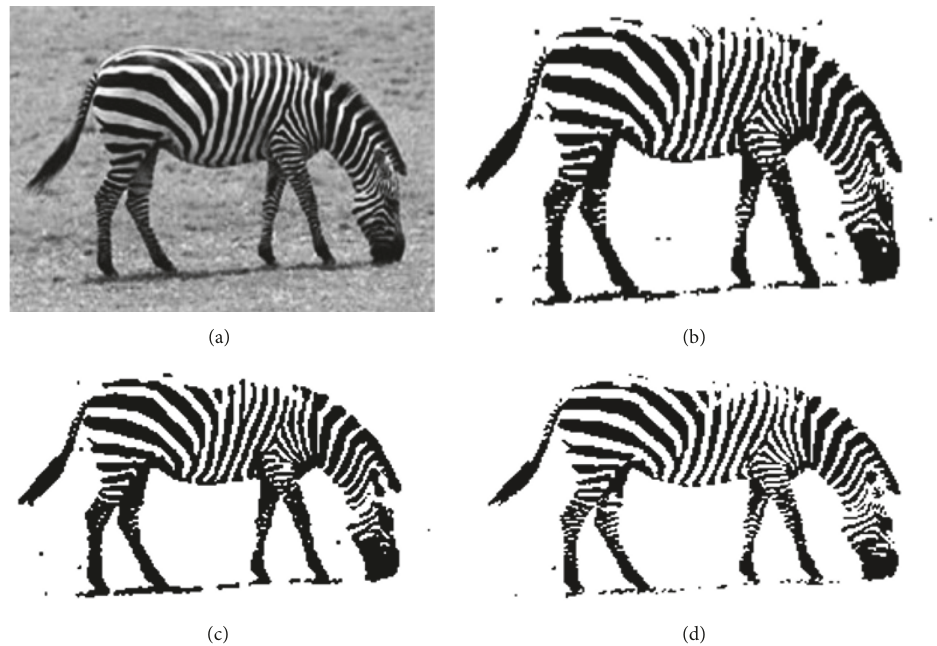
Figure 5: Segmentation of horse image. (a) Horse original. (b) Segmentation of one-dimensional Otsu. (c) The traditional two-dimensional Otsu method. (d) Our algorithm.